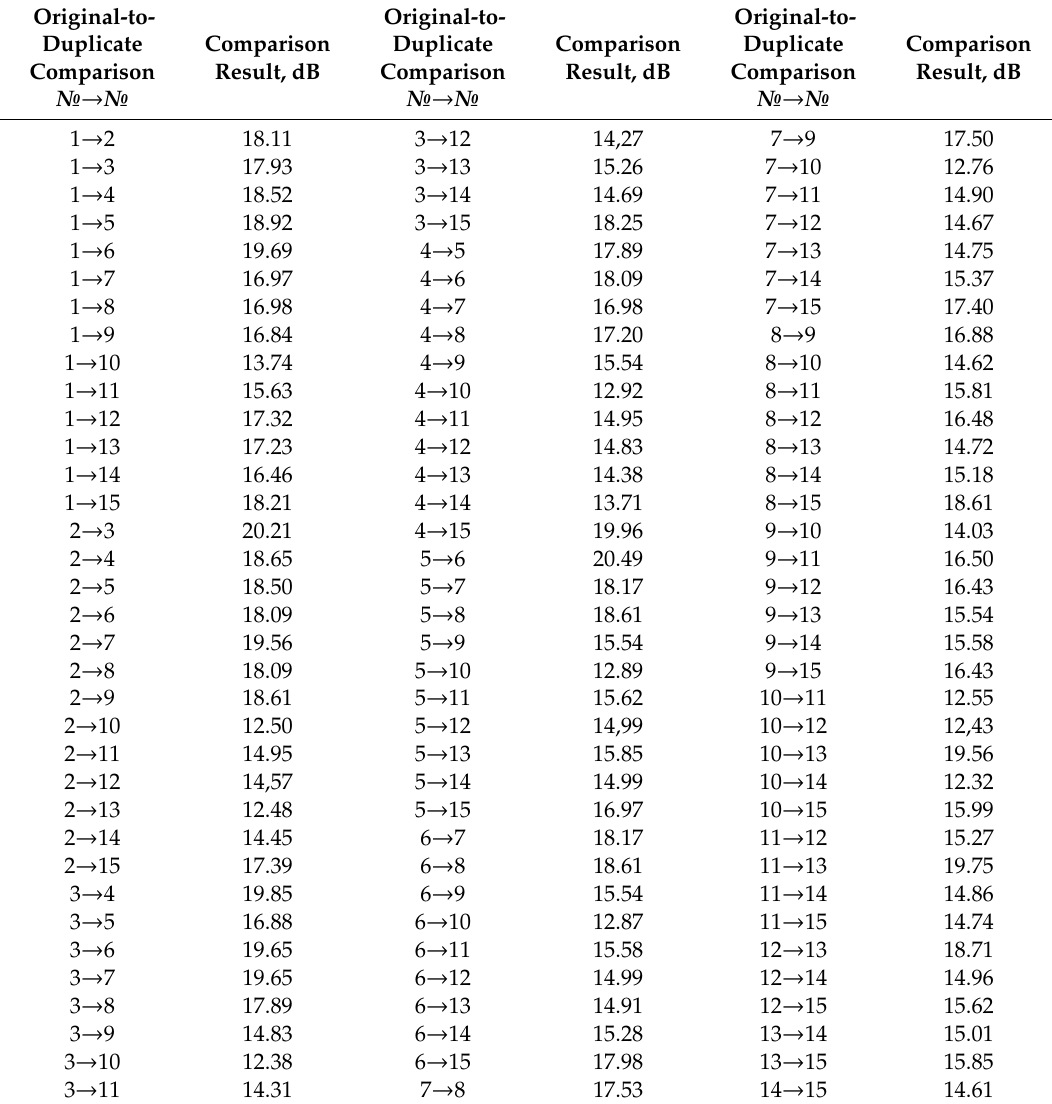
Table 3. The results of using the method of a complete pixel-by-pixel comparison between the original and duplicate, printed on o ff set machine on di ff erent paper